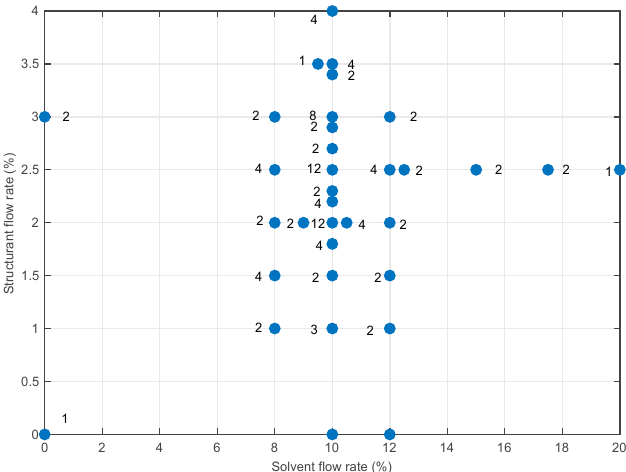
Figure 4. Map of the experiments that have been run in the pilot plant and their composition. The number next to the points is the number of replicates of that setting.